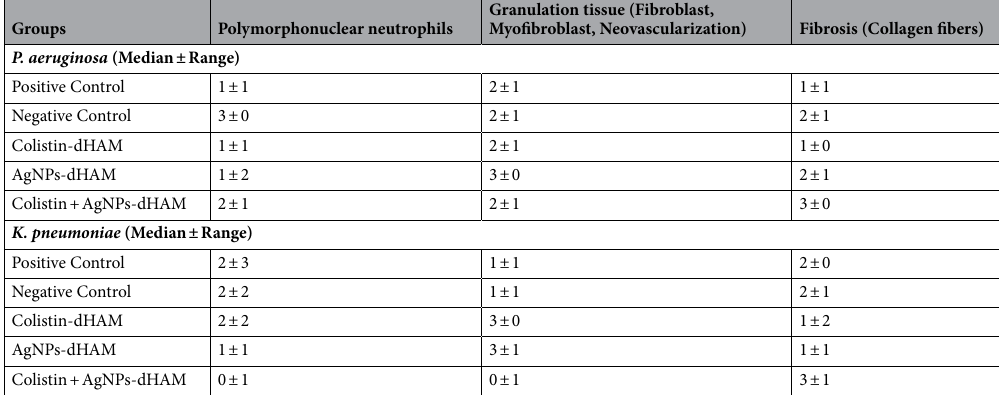
Table 5. Histological features of rat wound healing against P. aeruginosa and K. pneumoniae on day 21. 0 = Absent, + = 1, + + = 2, + + + = 3.